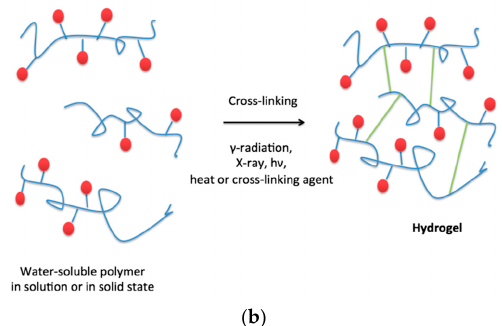
Figure 3. ( a ) Synthesis of hydrogels by polymerization of monomers and crosslinking agent; ( b ) Synthesis of hydrogels by cross-linking of pre-polymerized water-soluble polymers. Reproduced with permission from [16].